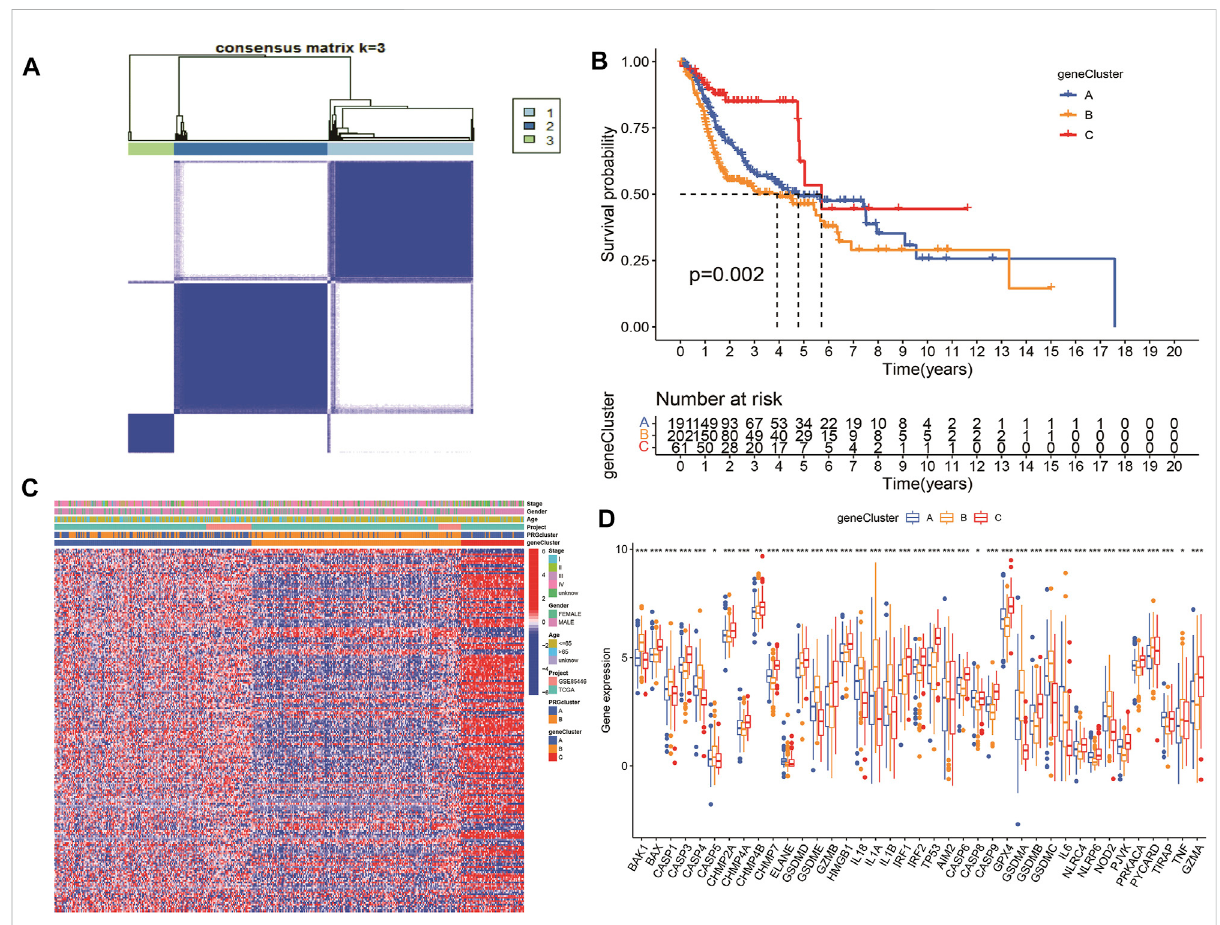
FIGURE 6 Survival analysis and variance analysis in pyroptosis-related genes correlated with prognosis. (A) Gene sample distribution of different clusters. (B) Different gene clusters in survival probability. (C) Gene expression and clinical correlation in different clusters showed in the heatmap clearly. (D) Differential expression of PRRs between the three groups. Asterisk represents the statistical p -value (* p < 0.05; ** p < 0.01; *** p <